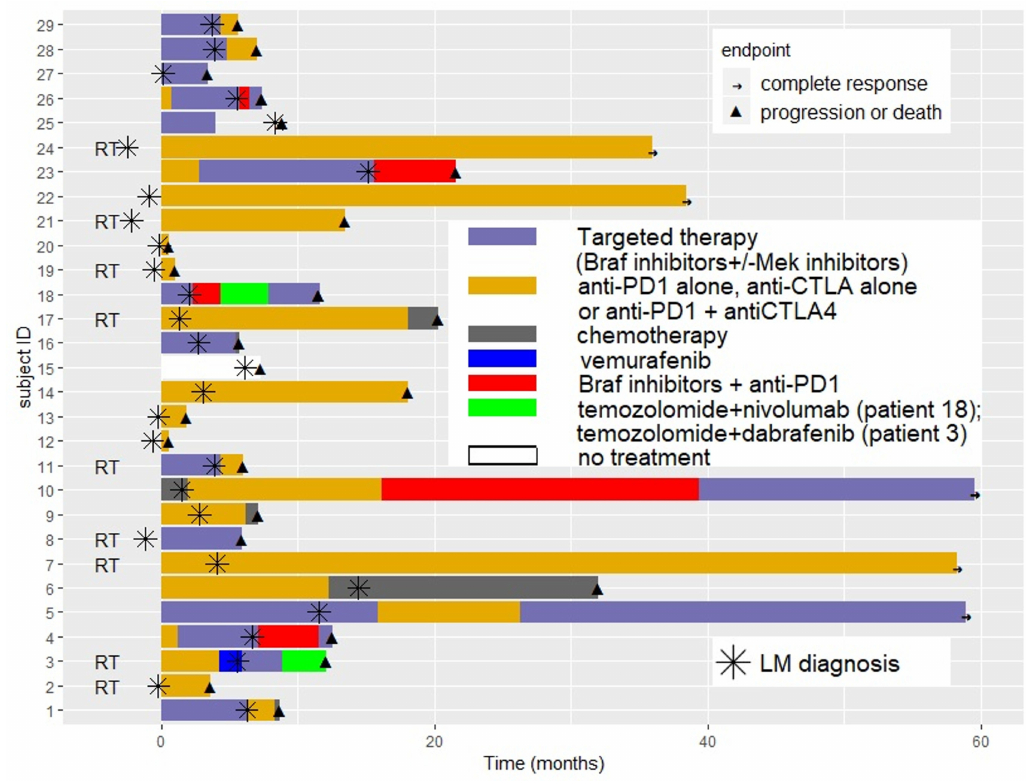
Figure 1. Sequence of systemic treatment and radiotherapy received before and after leptomeningeal disease diagnosis for each